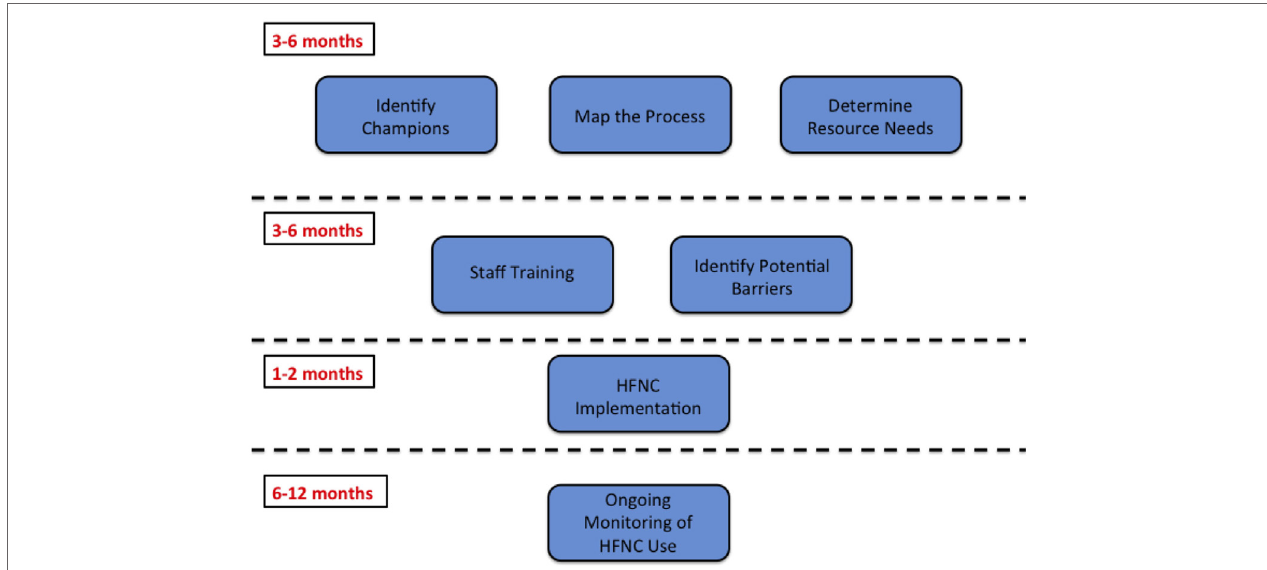
FiGUre 2 | High flow nasal cannula implementation